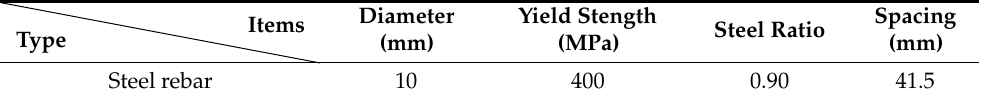
Table 4. Propertied of the used